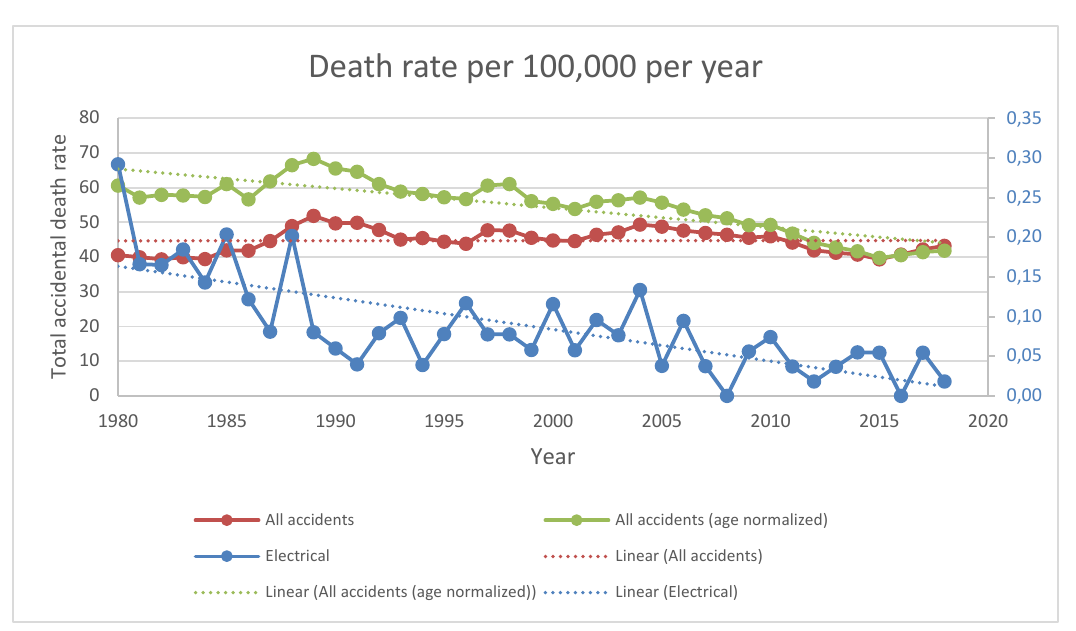
Figure 1. Electrical accident death rate per 100,000 inhabitants per year, compared to death rate due to all accidents